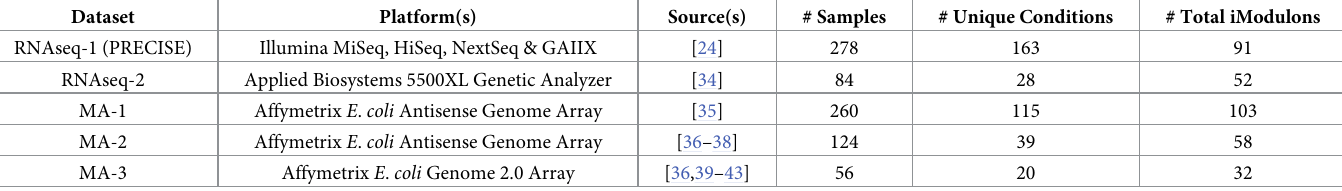
Table 1. Summary of transcriptomic